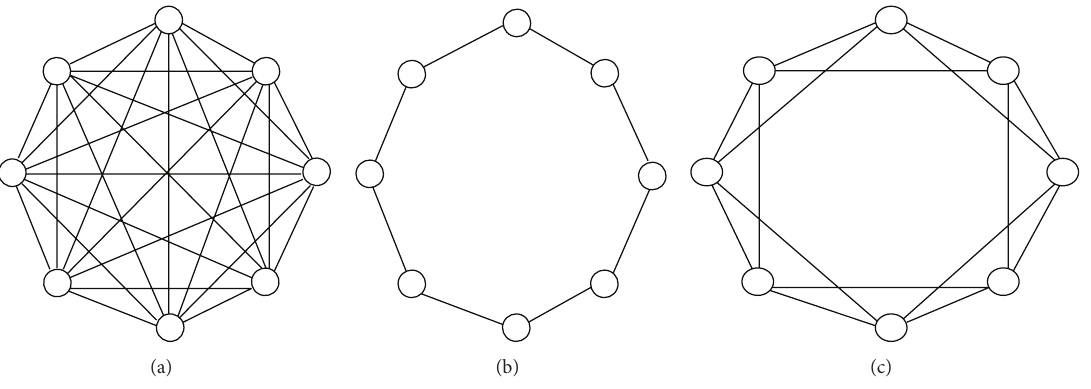
Figure 5: Topologies 𝐺 best (a), 𝐿 best with 𝑘 = 2 (b) and 𝑘 = 4 (c).